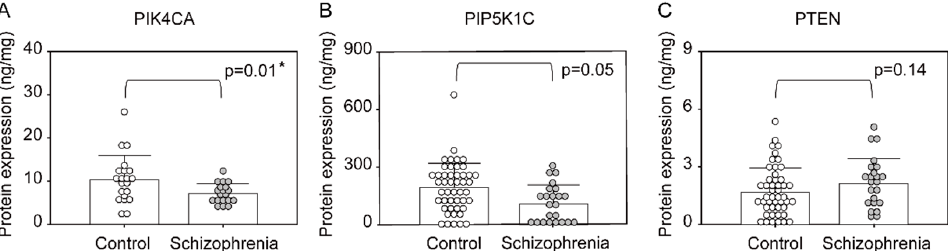
Figure 3. Expression levels of phosphoinositide signaling-associated proteins in the prefrontal cortex of patients with schizophrenia and controls. ( A ): PIK4CA, ( B ): PIP5K1C, ( C ): PTEN. Means ± SD are shown as bars and whiskers. * p < 0.05.